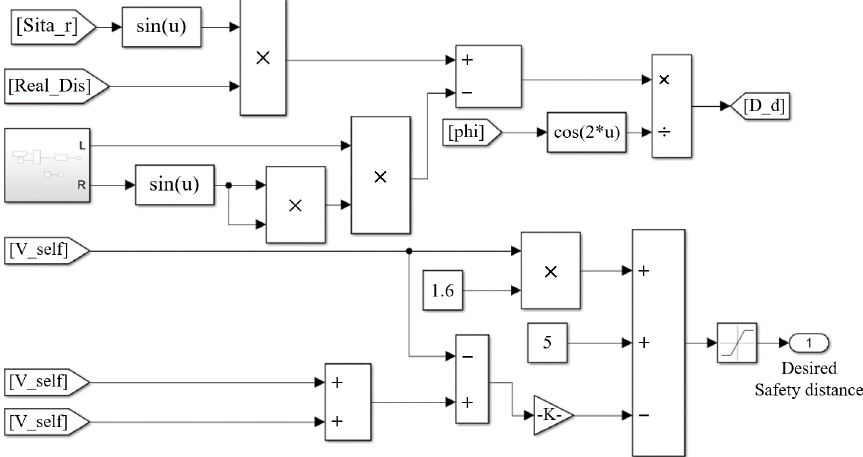
Figure 4. Safety distance